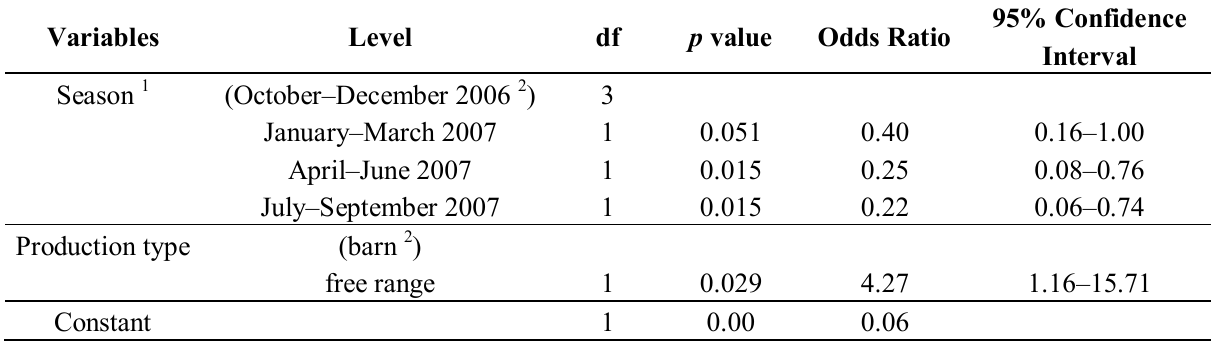
Table 7. Summary results of logistic regression on the probability of Salmonella presence in turkey fattening flocks with respect to season, region and production